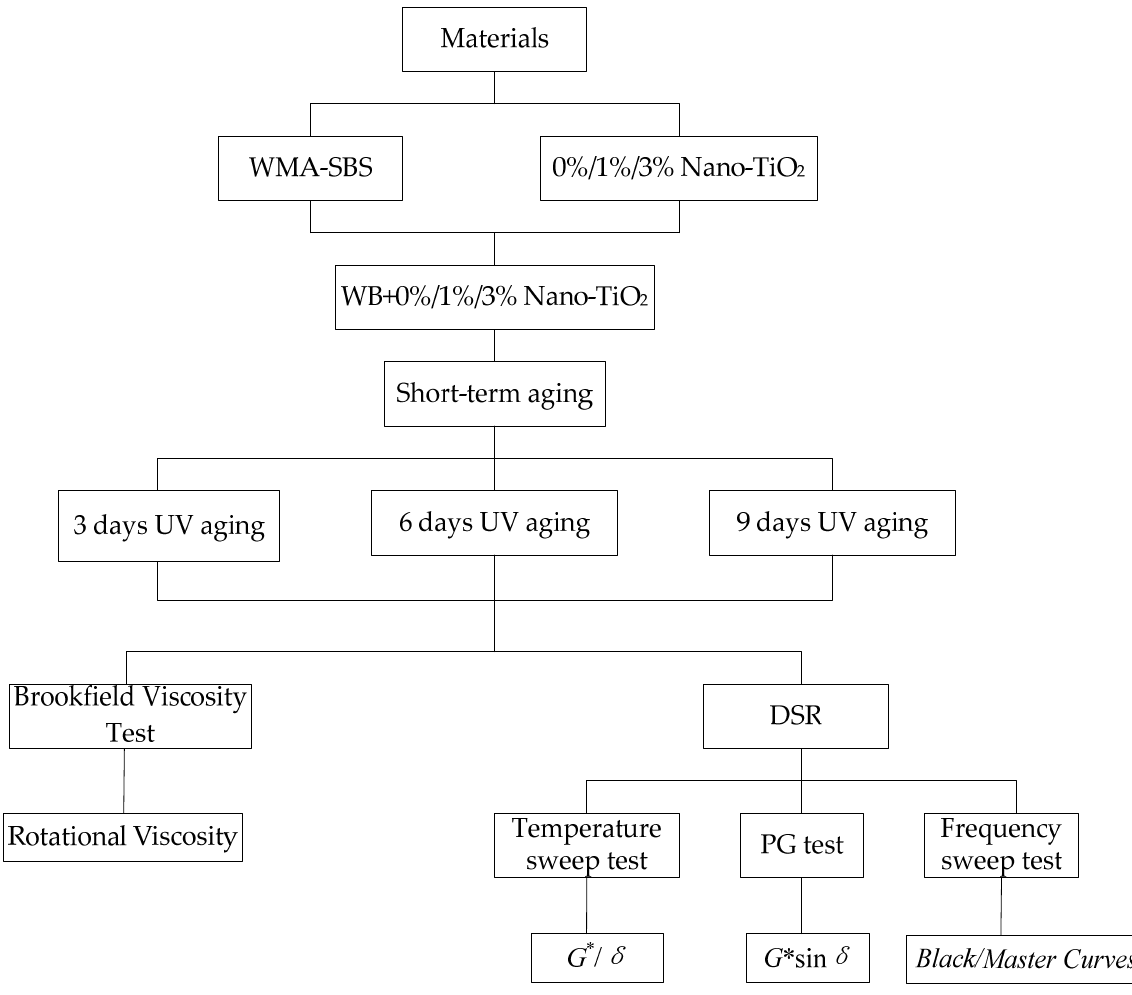
Figure 1. Flowchart of experimental procedure.